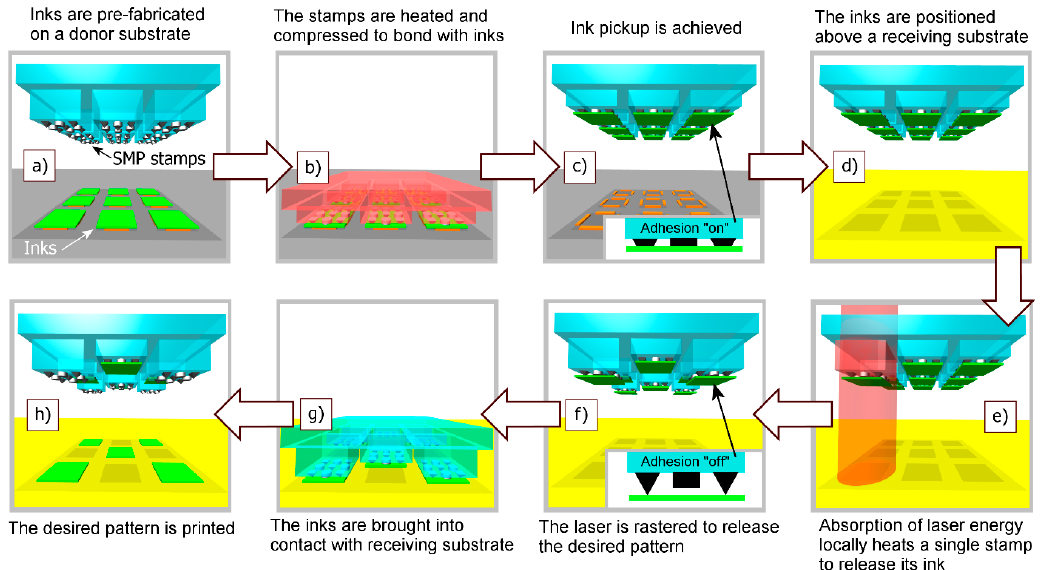
Figure 5. The operation of the laser-driven CBSMP transfer printing process is depicted. Reproduced with permission from